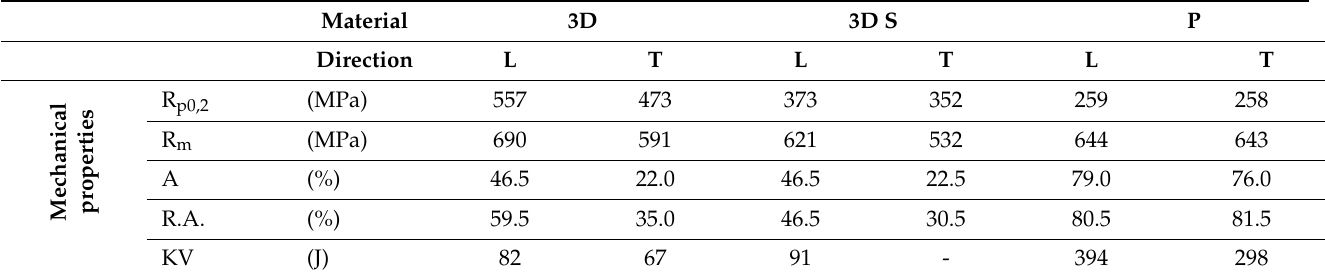
Table 2. Results of mechanical tests.